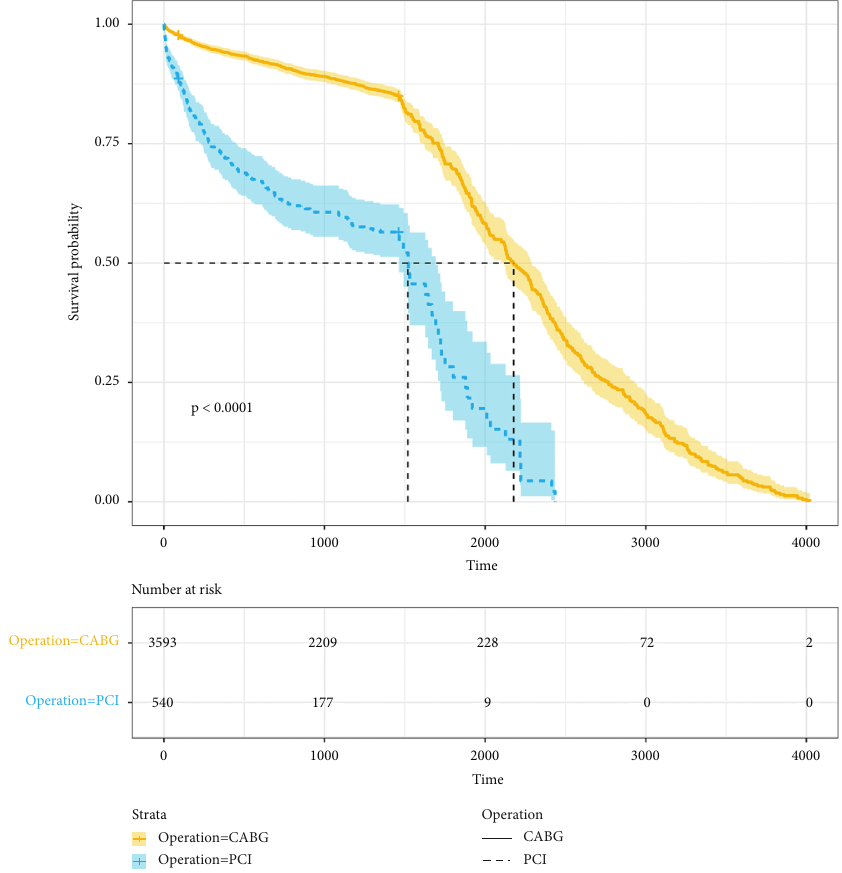
Figure 2: Kaplan–Meier survival curves for all-cause